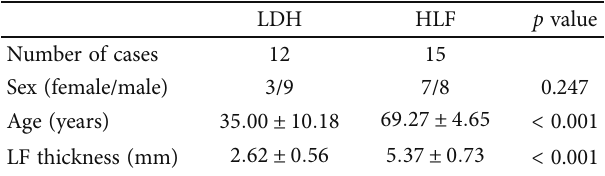
Table 1: Patient